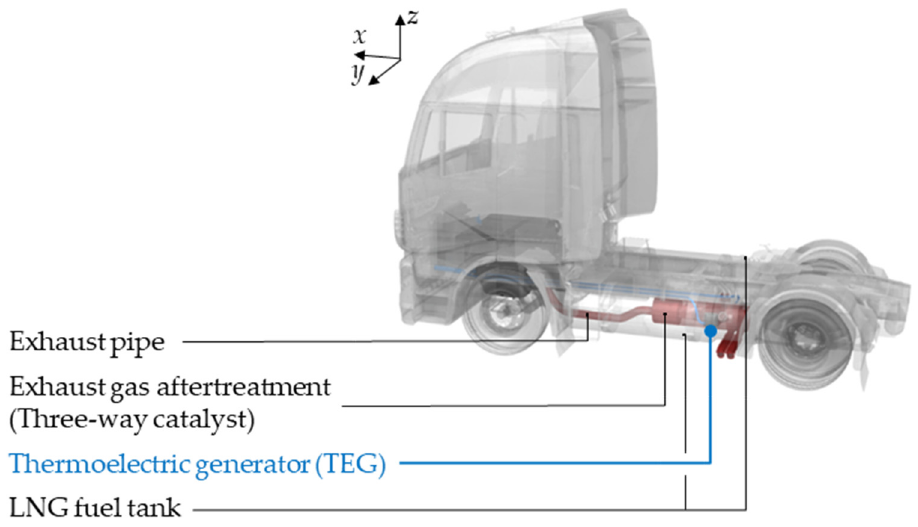
Figure 8. Vehicle integration of the TEG system in a tractor unit of a natural gas HDV.